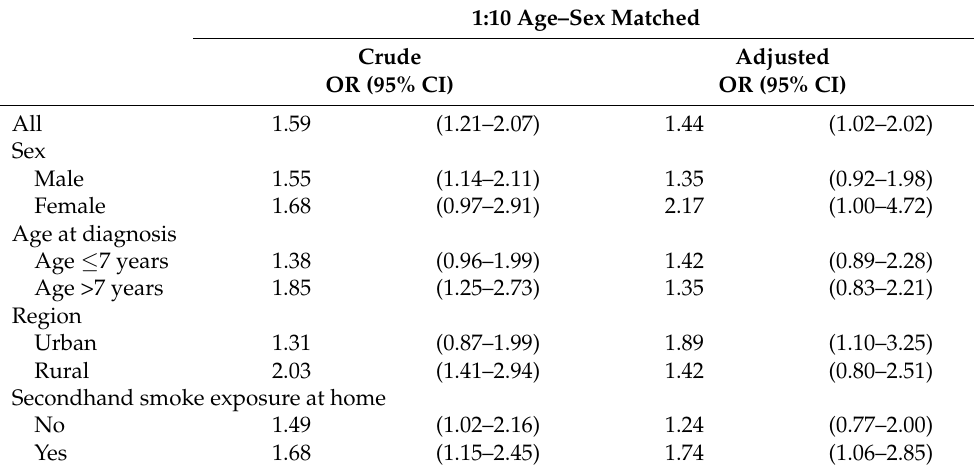
Table 3. Association * between a 10 µ g/m 3 increase in PM 10 concentration and ADHD: stratification by sex, age at diagnosis, region, and secondhand smoke exposure at home, for KNHANES 2008–2018 (n =